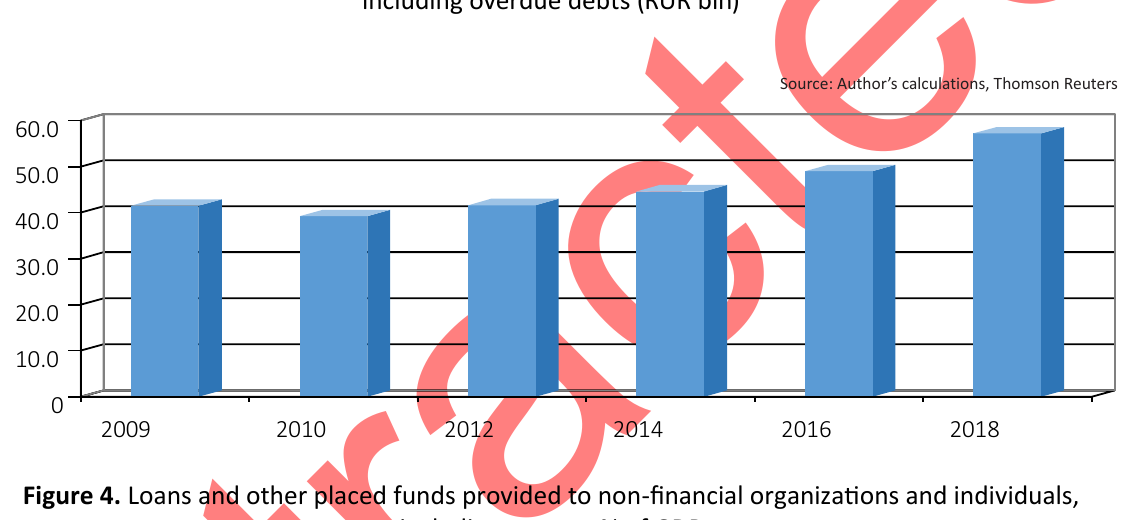
Figure 4. Loans and other placed funds provided to non-financial organizations and individuals, including arrears, % of